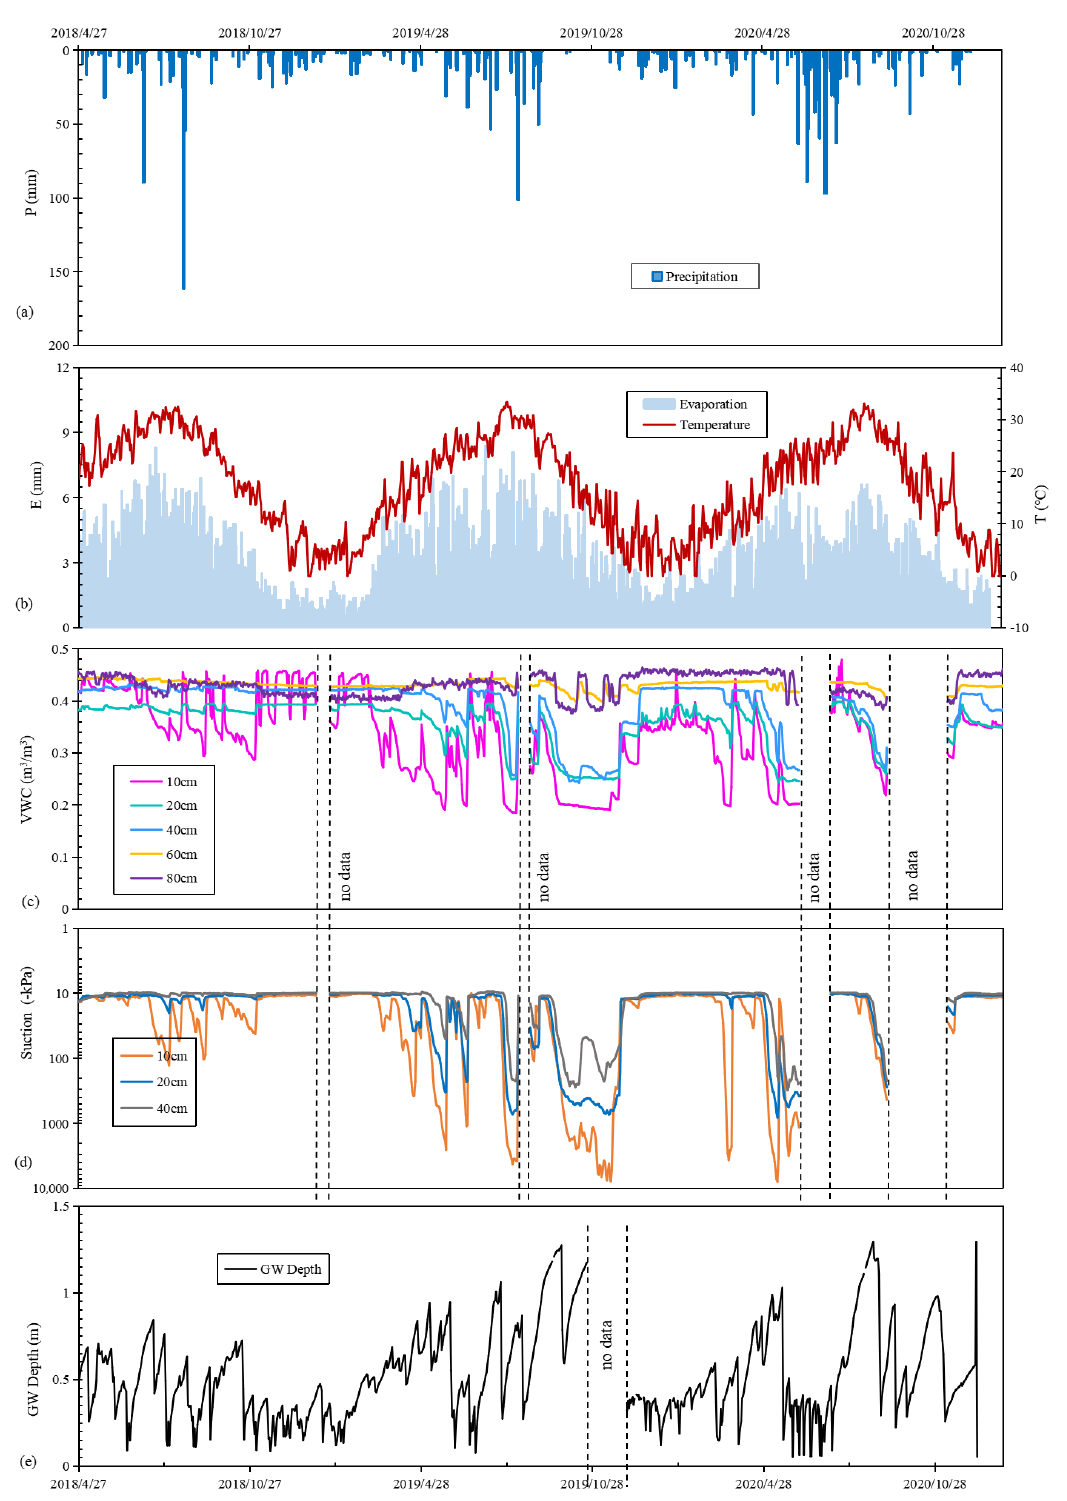
Figure 5. Meteorological and hydrological characteristics, soil moisture content and suction dy- namics in the BTQ area from 2018/4/26 to 2021/1/9: ( a ) precipitation process, ( b ) daily evaporation and temperature, ( c ) soil water content of each horizon, ( d ) soil suction of each horizon and ( e ) ground−water depth.